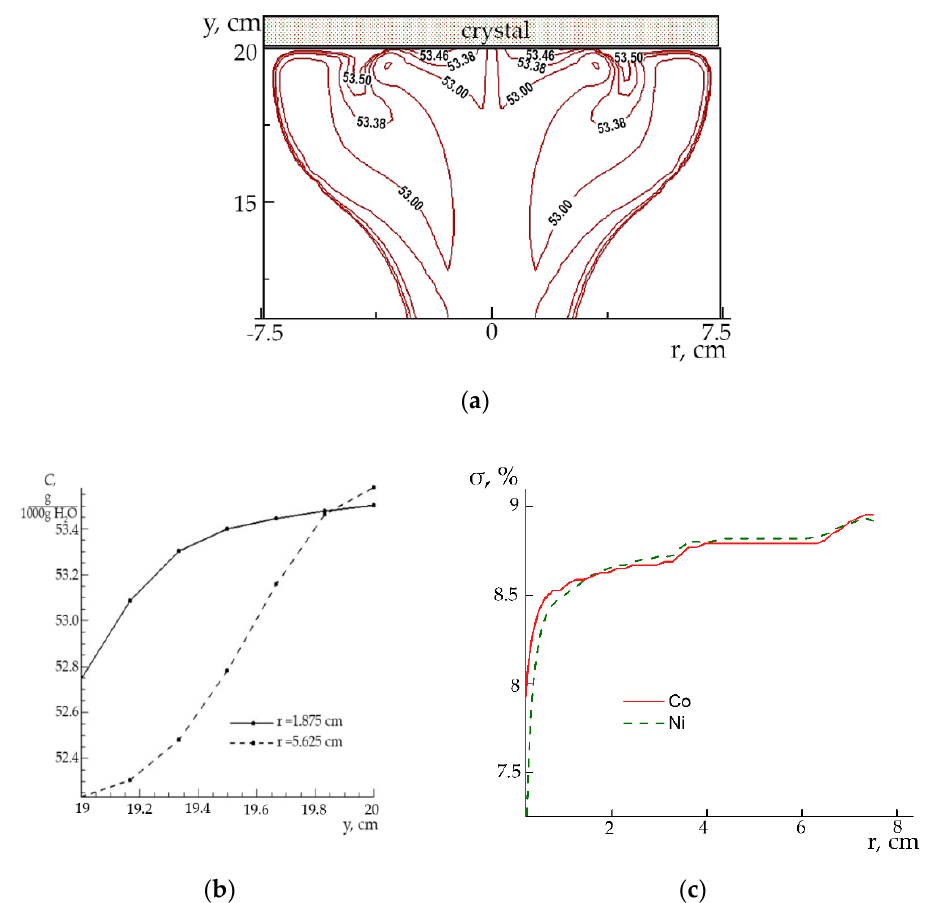
Figure 8. The turbulent flow during a peripheral solution supply: ( a ) KCSH concentration isolines (g/1000 g H 2 O) in the meridional plane and ( b ) longitudinal profiles of Co component concentration in the boundary layer; ( c ) radial supersaturation profiles at the crystal surface for Co and Ni components, the supersaturation in the inward jet area σ = 9.0% and the inflow velocity V jet = 200 cm/s.